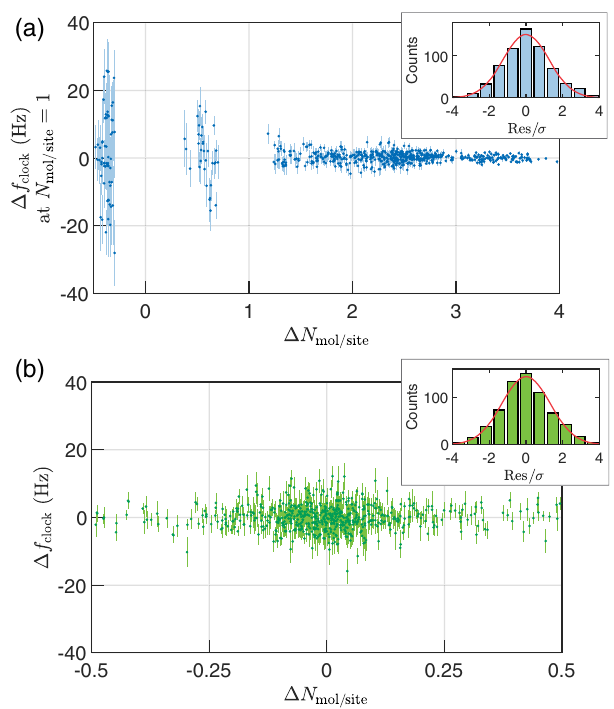
FIG. 4. Density-shift evaluation. (a) Clock shifts due to molecular collisions extrapolated to operating conditions (one molecule per lattice site, averaged over filled sites) plotted versus the change in molecule number per site used for the interleaved measurement. A single constant suffices to fit the data [0.20(10) Hz, χ 2 ¼ 1 . 7 ]. (b) In the same dataset, the shift red between successive resonances taken under identical experimen- tal settings serves as a control experiment to check for technical offsets. As expected, this averages to zero [0.03(20) Hz, ffiffiffiffiffiffiffi p χ 2 χ 2 . Error ¼ 2 . 0 ]. All statistical errors are scaled up by red red bars represent 1 σ uncertainties. Both insets show the histogram of normalized residuals, and the solid red lines are Gaussian